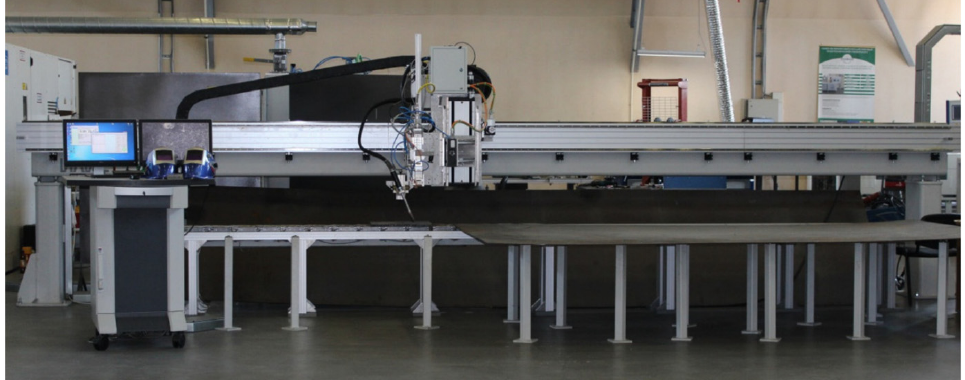
Figure 1. External view of the technological laser complex. Table 1. Technical characteristics of the technological complex.